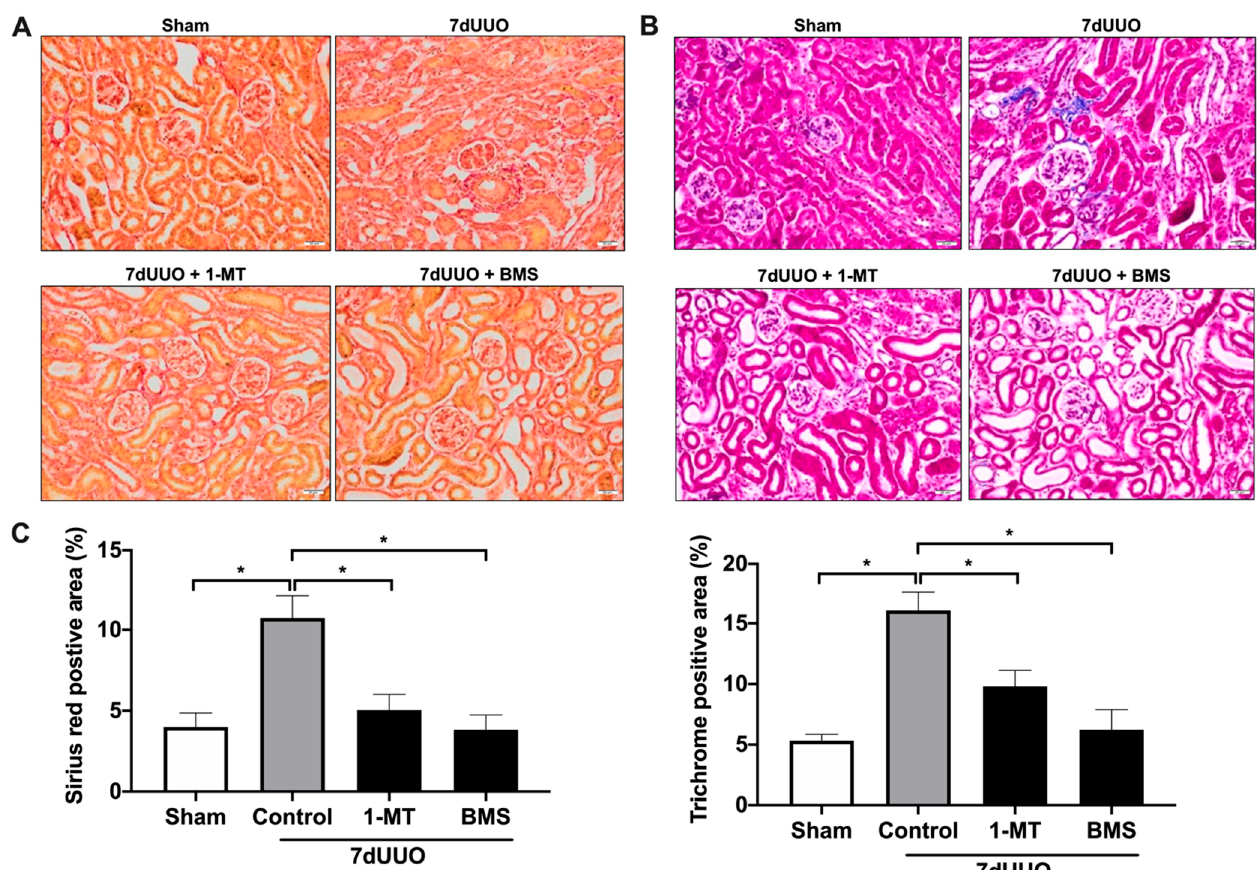
Figure 6. 1-Methyl-D-tryptophan and BMS-986205 markedly reduce collagen deposition in UUO mice. Mice were subjected to 7 days of unilateral ureteral obstruction (UUO) and treated with either 1-methyl-D-tryptophan (10 mg/mL) or BMS-986205 (10 mg/mL). ( A ) Representative images of Picrosirius red staining. ( B ) Representative images of Masson’s trichrome staining. ( C ) Quantification of Picrosirius red and Masson’s trichrome staining as a percentage of the total area of the tissue from Sham and UUO mice. Magnification 20 × . Scale bar: 20 µ m. n = 3–5. Data are presented as mean ± SEM. * p < 0.05.